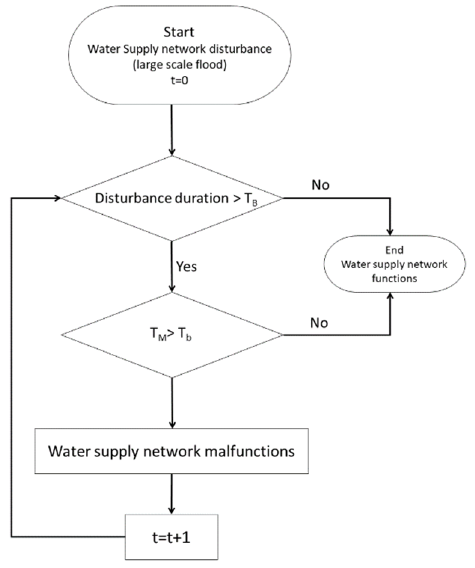
Figure 8. Flow diagram of the water supply network performance simulation under a large flood.